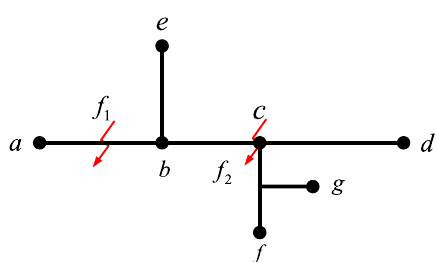
Fig. 3 Failure schematic diagram of simple distribution